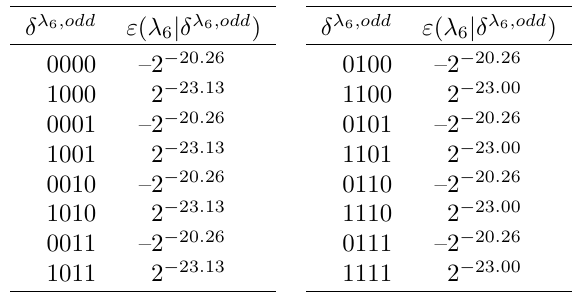
Table 12: Conditioning ε ( λ 6 ) on Each of the 16 Possible Values of δ λ 6 ,odd